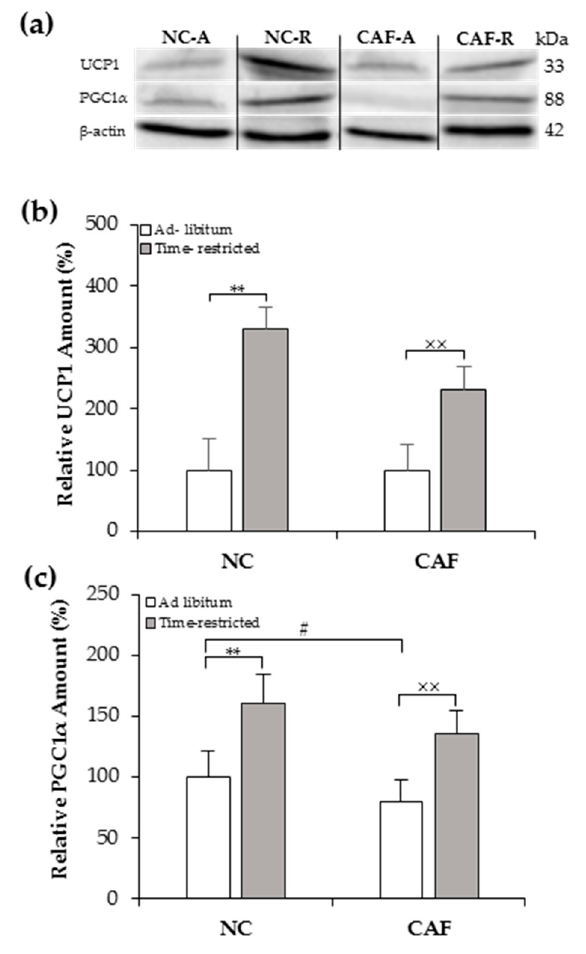
Figure 4. E ff ects of time-restricted feeding on thermogenic protein levels in the inguinal WAT of normal chow and cafeteria fed rats as measured by Western blot: ( a ) representative blot of UCP1 and PGC1 α ; ( b , c ) densitometry quantification of UCP1 and PGC1 α protein levels. NC–A: normal chow ad libfeeding; NC–R: normal chow time-restricted feeding; CAF–A: cafeteria diet ad libfeeding; CAF–R: cafeteria time-restricted feeding; NC: normal chow diet; CAF: cafeteria diet.Values are means ±S.D (n = 3) of ratios of specific protein levels to β - actin (Loading protein). Data of the NC–A group wereset to 100% and the rest of the values are referred to this. # p < 0.05 CAF–A vs. NC–A rats; **